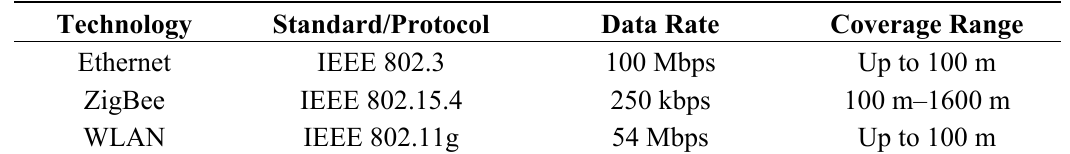
Table 2. Comparison between different communication technologies applicable for microgrid.